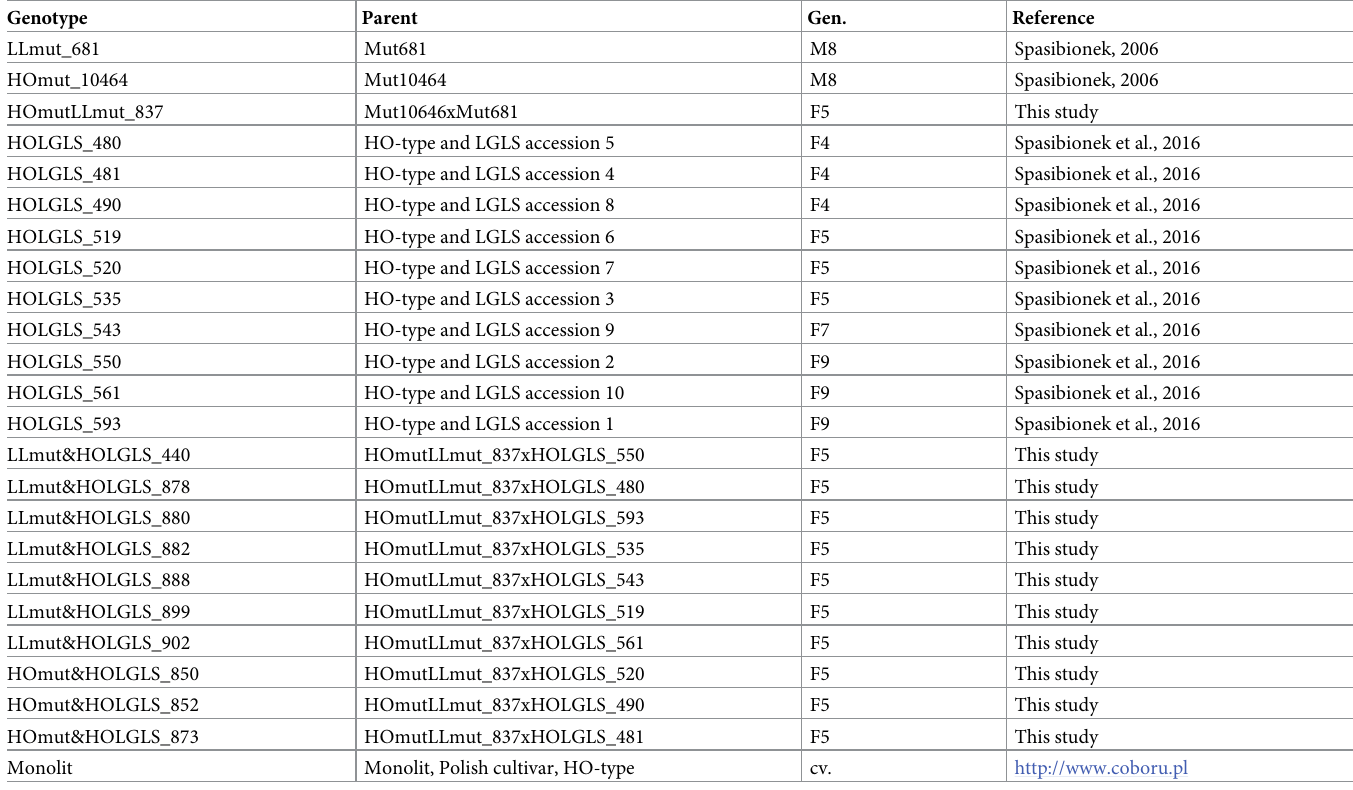
Table 1. Plant material used in this